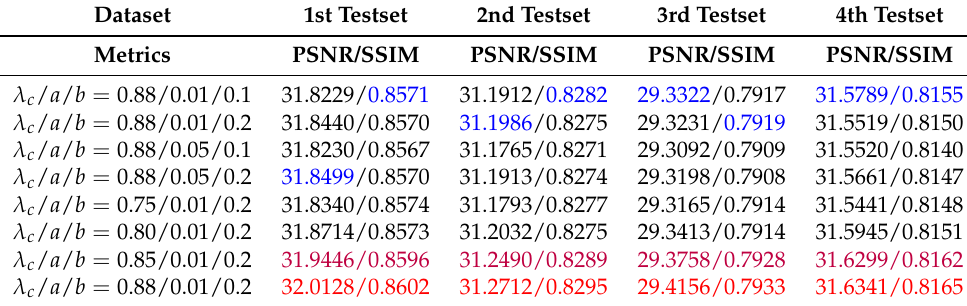
Figure 8. Visual comparison between FCGSR and our FCSR method of ×4 factor on various test sets. We enlarge the image details inside the light red rectangle and show in the red rectangle in the upper right corner. Table 5. Results of average PSNR and SSIM results of different SVD coefficients on four test sets. Red index denotes the best performance. Blue index suggests the suboptimal performance for adjusting a and b . Purple index suggests the suboptimal performance for adjusting λ c